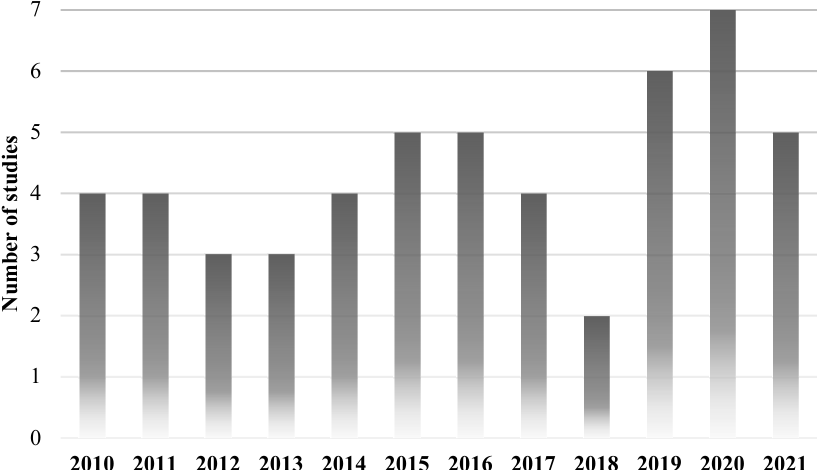
Figure 4. Evolution of the number of publications. The sample consists of 15 papers indexed in Scopus between Q1 and Q4, two papers indexed in ESCI WoS, seven papers with other indexations, four book chapters, and 24 papers published in conference proceedings (Figure 5).